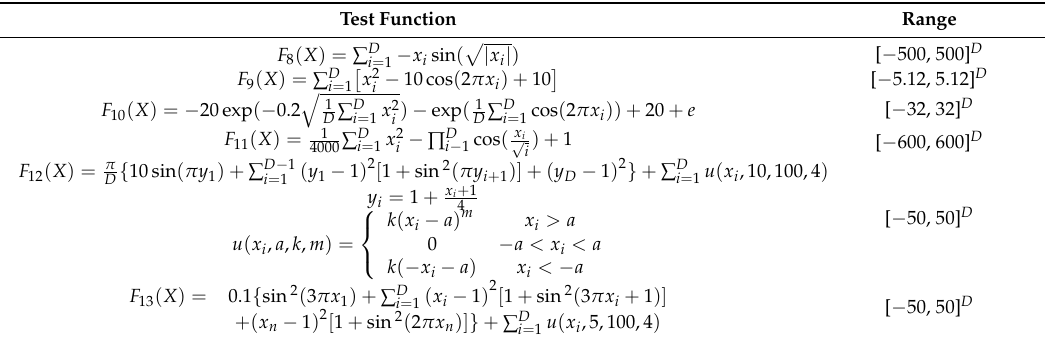
Table 2. Multimodal test function ( D =